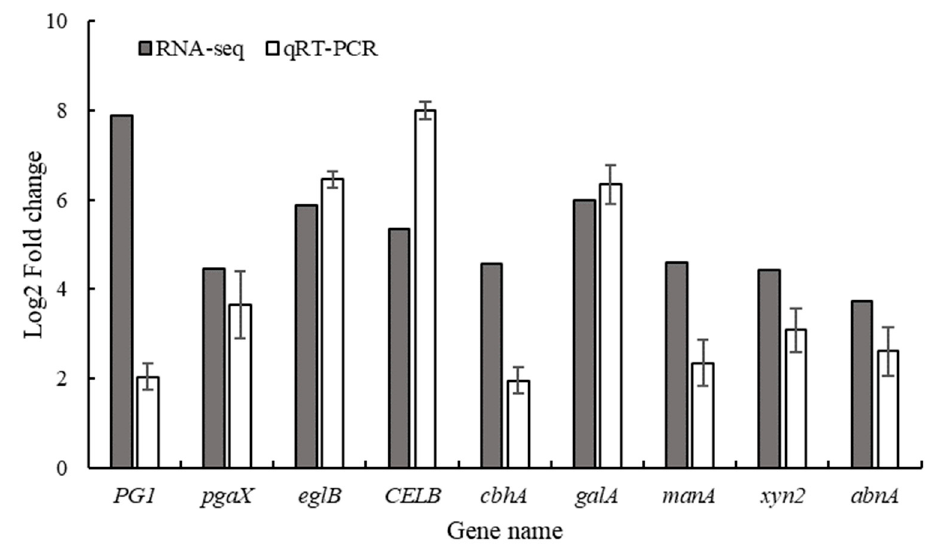
Figure 6. qRT-PCR validation for differentially expressed genes related to cell wall degrading enzymes.